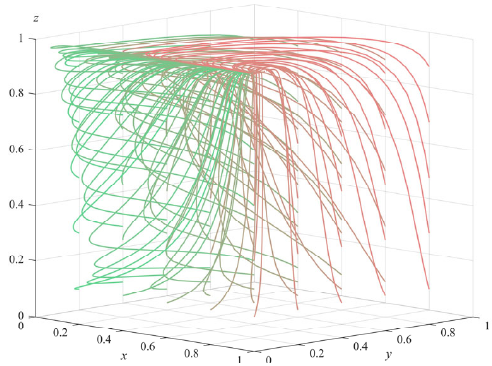
Figure 3. Simulation results of Proposition 3.